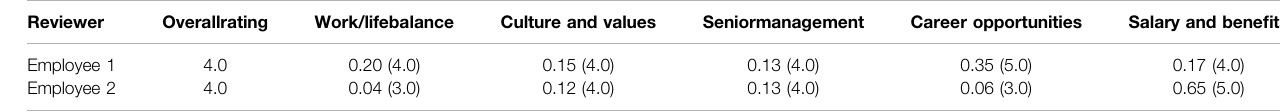
TABLE 3 | The difference in aspect weight of the two employees ’ published texts. Reviewer